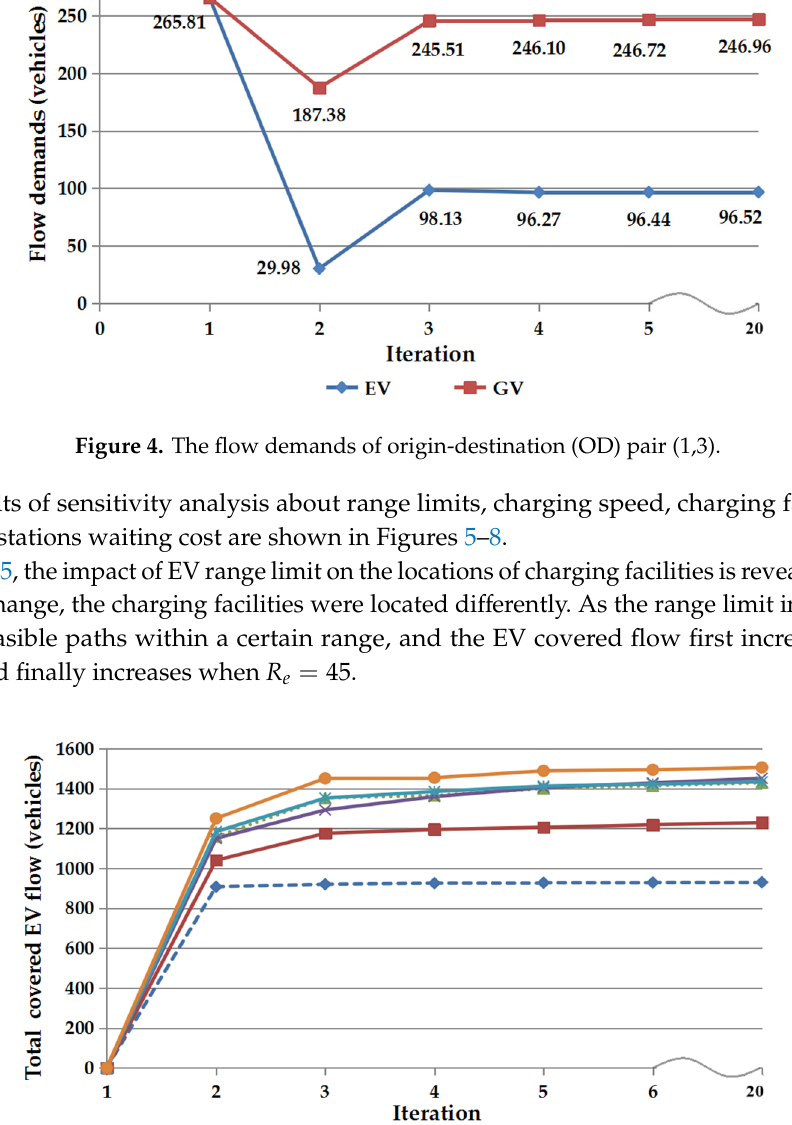
Table 4. The changes in the location of charging stations (CSs) and feasible paths. 306